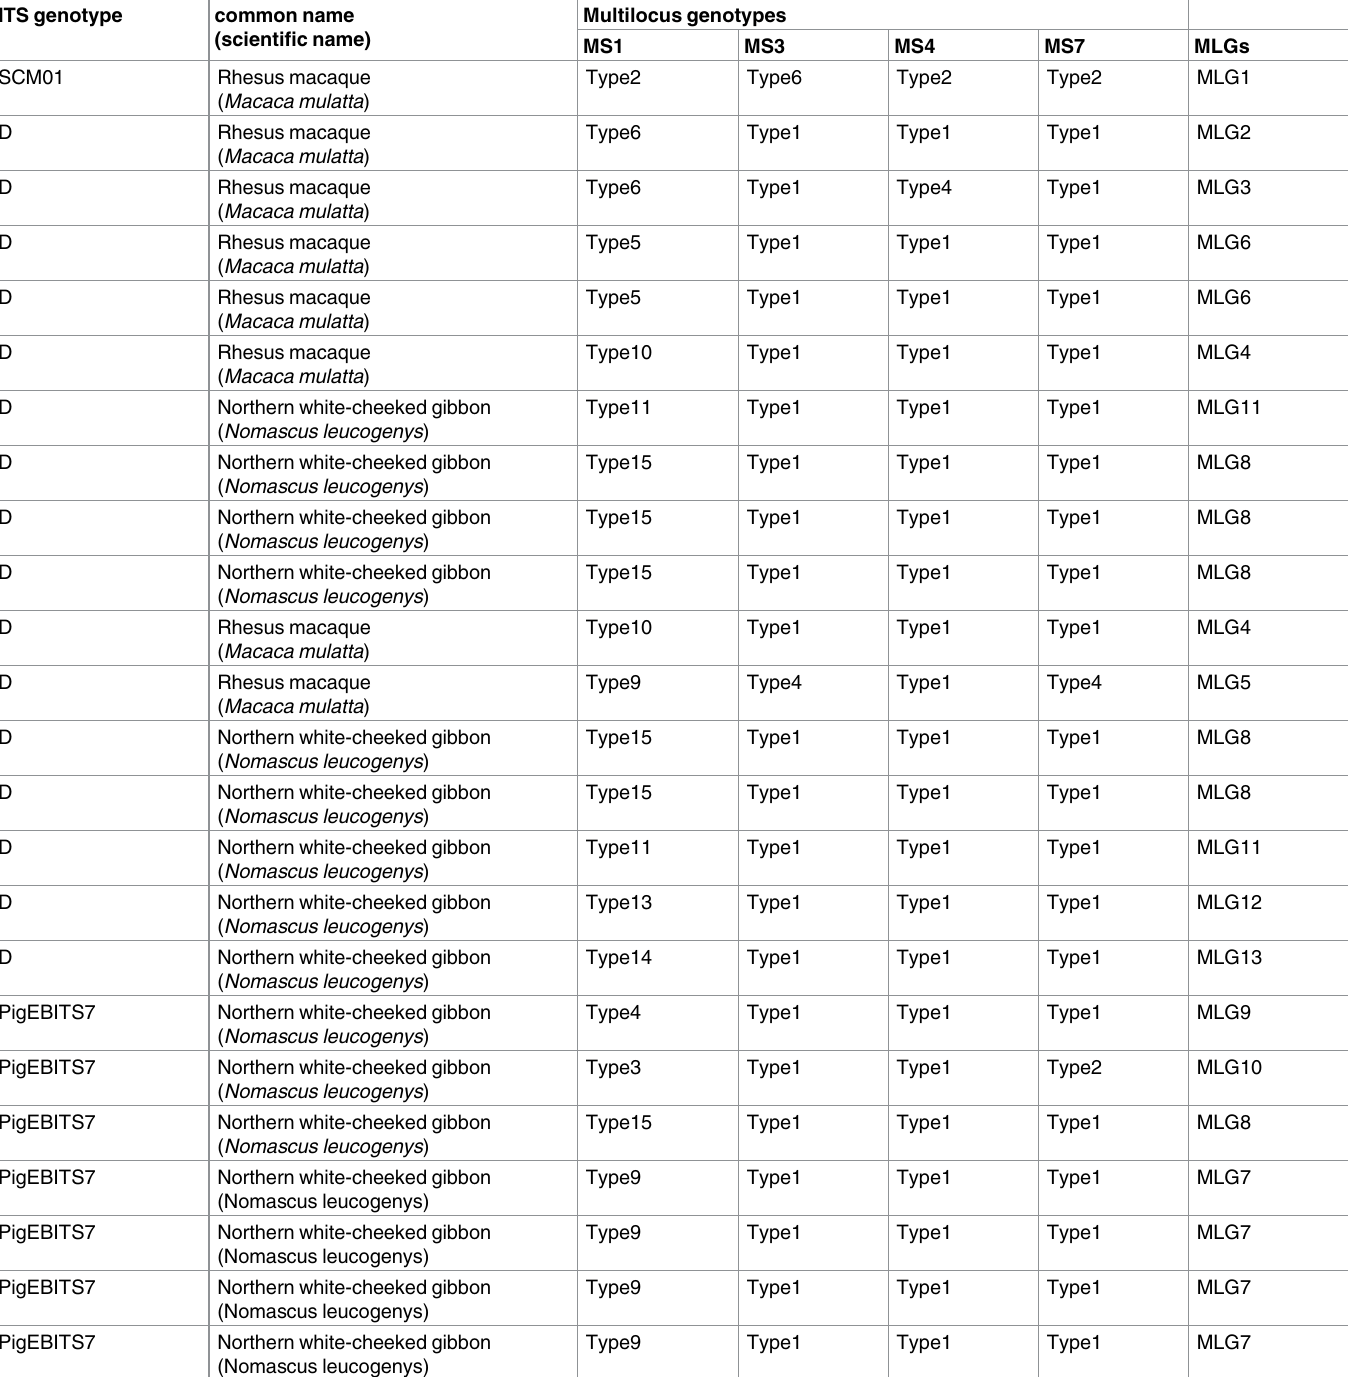
Table 2. Multilocus genotypes of Enterocytozoon bieneusi from nonhuman primates. ITS